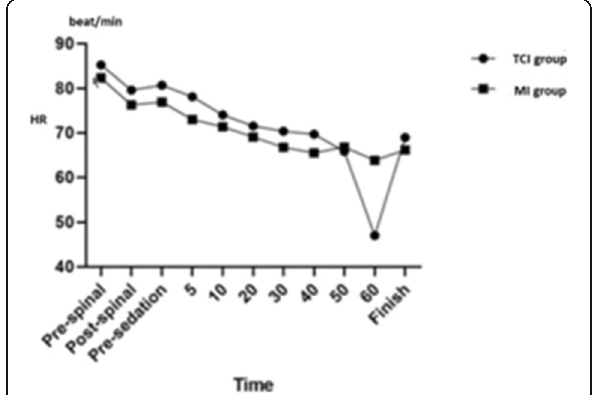
Fig. 5 Changes in Bispectral Index Scale. Values are mean ±